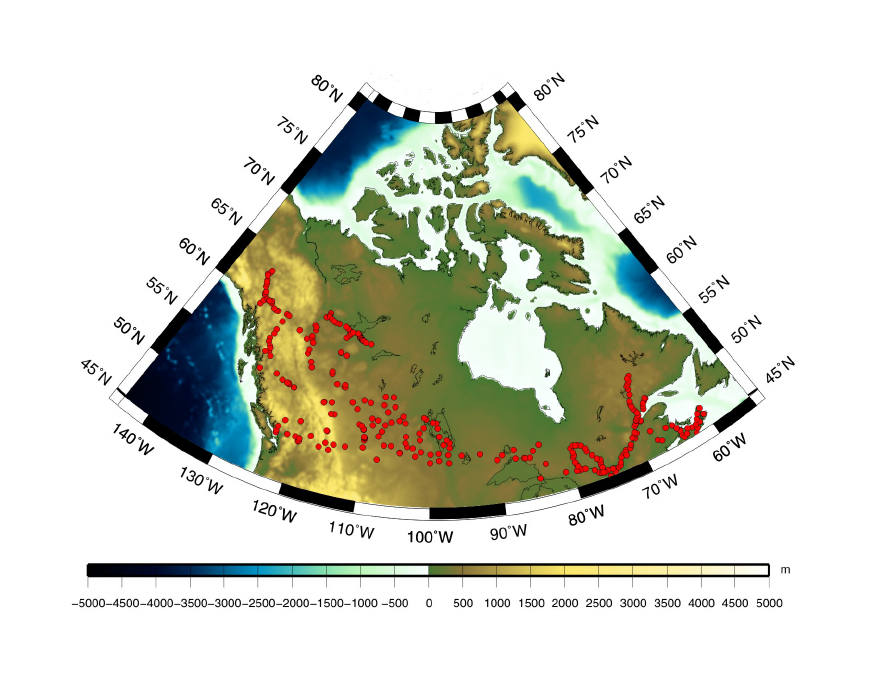
Figure 1. Distribution of 308 GNSS/levelling benchmarks common in Nov07, CGVD28, and NAVD88 vertical datums.